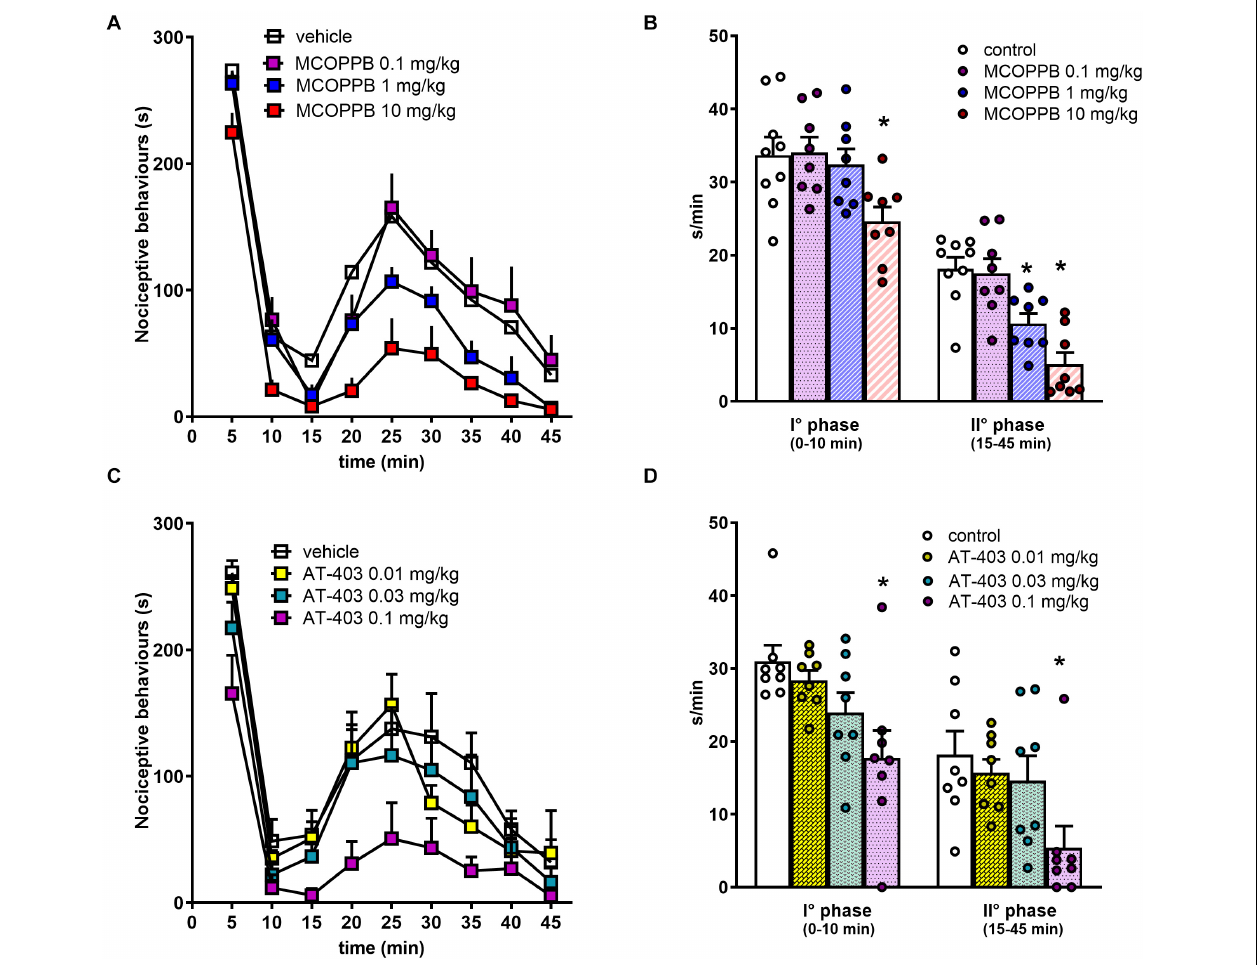
FIGURE 6 | Formalin test in CD-1 mice, dose response curves to MCOPPB and AT-403 injected i.p. (A,C) time course of formalin–induced pain behavior. (B,D) Cumulative formalin–induced pain behavior during the I ◦ and II ◦ phases. Each point represents the mean ± SEM of 8 mice/group. One-way ANOVA revealed an effect of MCOPPB in the first F ( 3 , 28 ) = 4.05 and second F ( 3 , 28 ) = 13.98 phase, and an effect of AT-403 in the first F ( 3 , 28 ) = 4.71 and second phase F ( 3 , 28 ) = 3.65. * p < 0.05 vs. vehicle, Dunnett’s test.